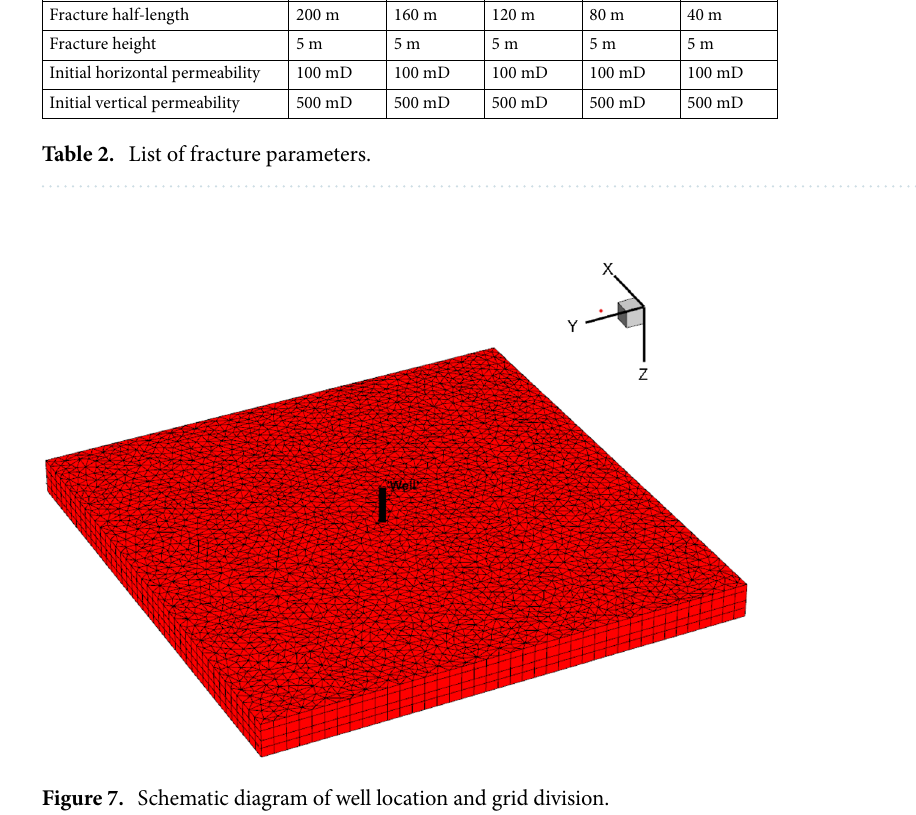
Figure 7. Schematic diagram of well location and grid division.